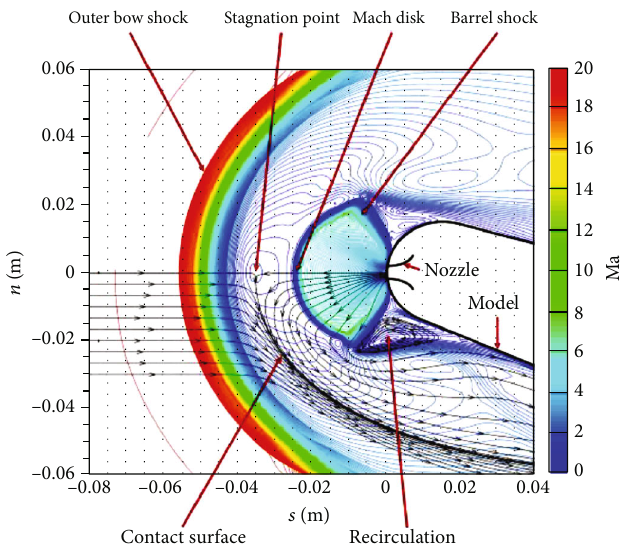
Figure 10: Mach number contour lines with streamlines for cases H70Ma20-J. Table 4: Summary of computed surface heat transfer properties (with ^ meaning the same as above).